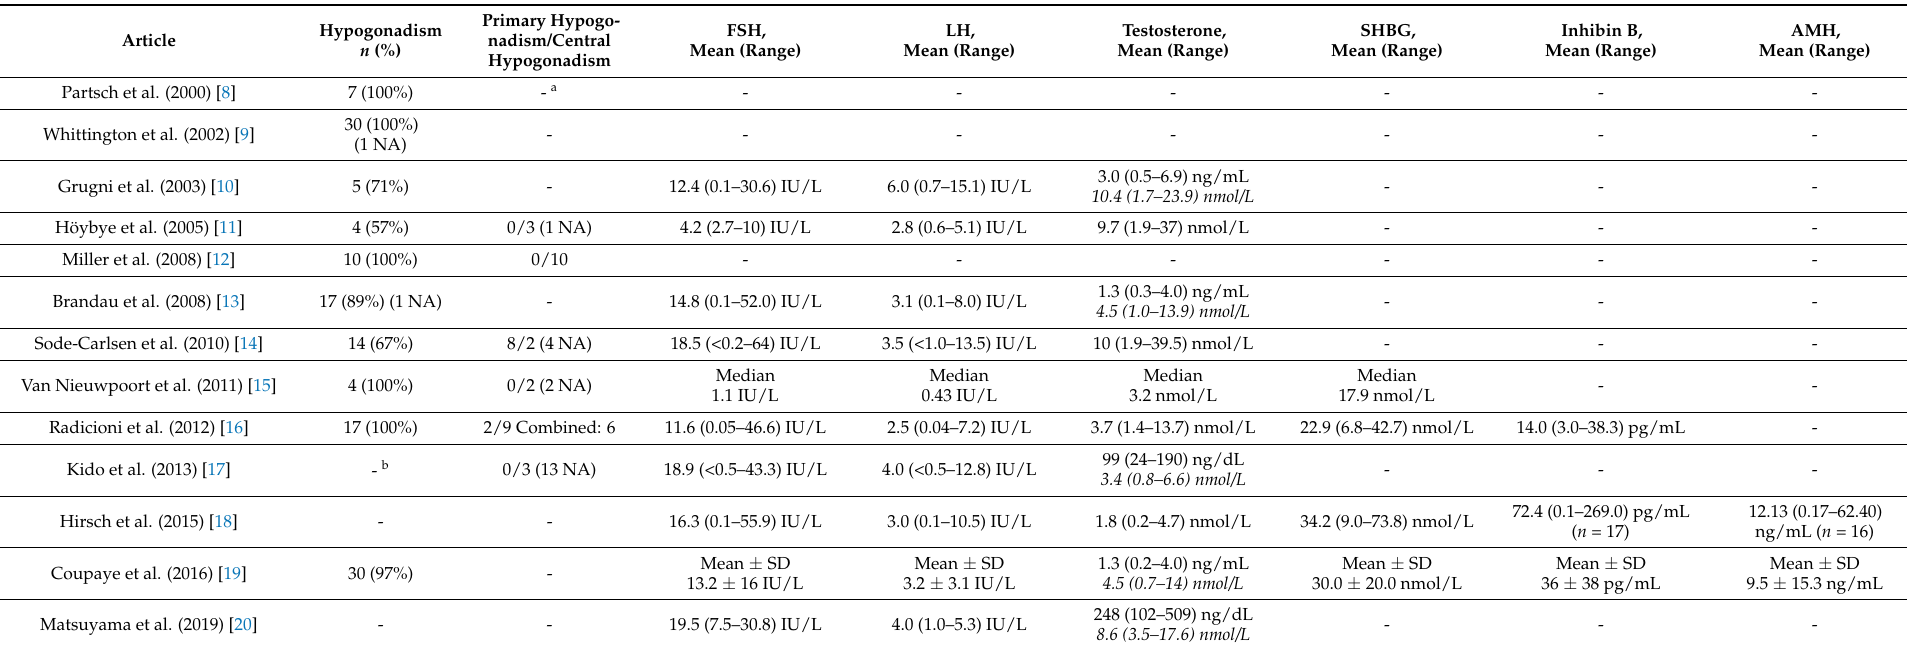
Table 6. Literature review hypogonadism in male adults with PWS (Part